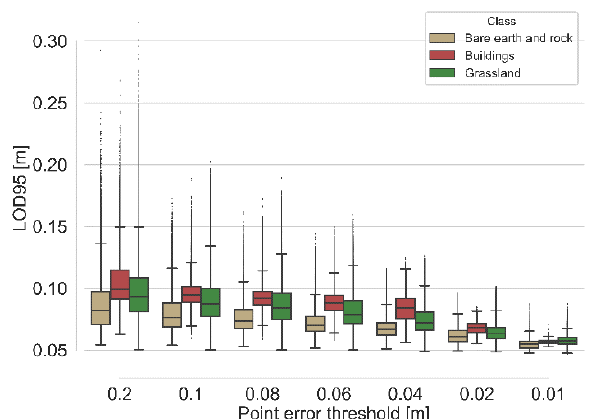
Figure 5. Level of detection (LOD 95 ) for different surface classes with various point error thresholds ( t pe ) used for filtering the point clouds.